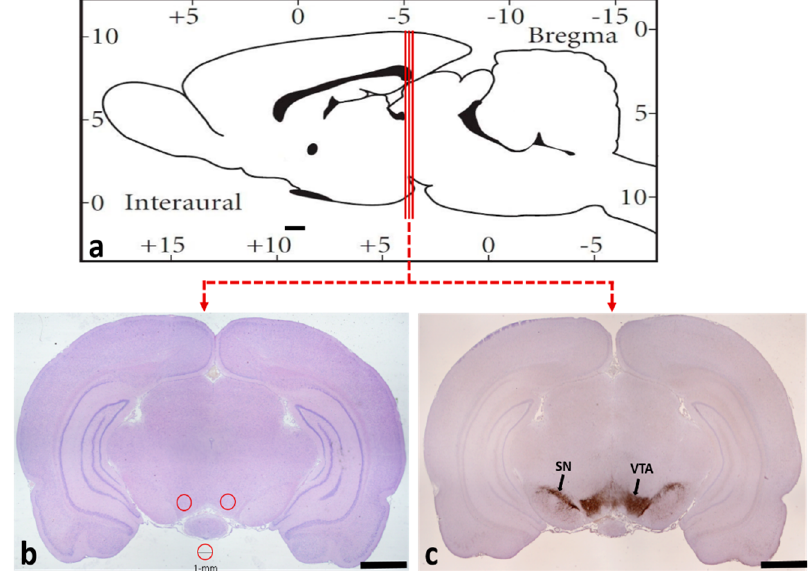
Figure 8. ( a ) The locations of the razor blades used to cut two adjacent VTA coronal slices are indicated in a sagittal view of the rat brain; ( b ) the punch placement in the consecutive coronal sections of the VTA (red circles); ( c ) the section with the largest area of the VTA. Bars = 1.6 mm in ( b – c